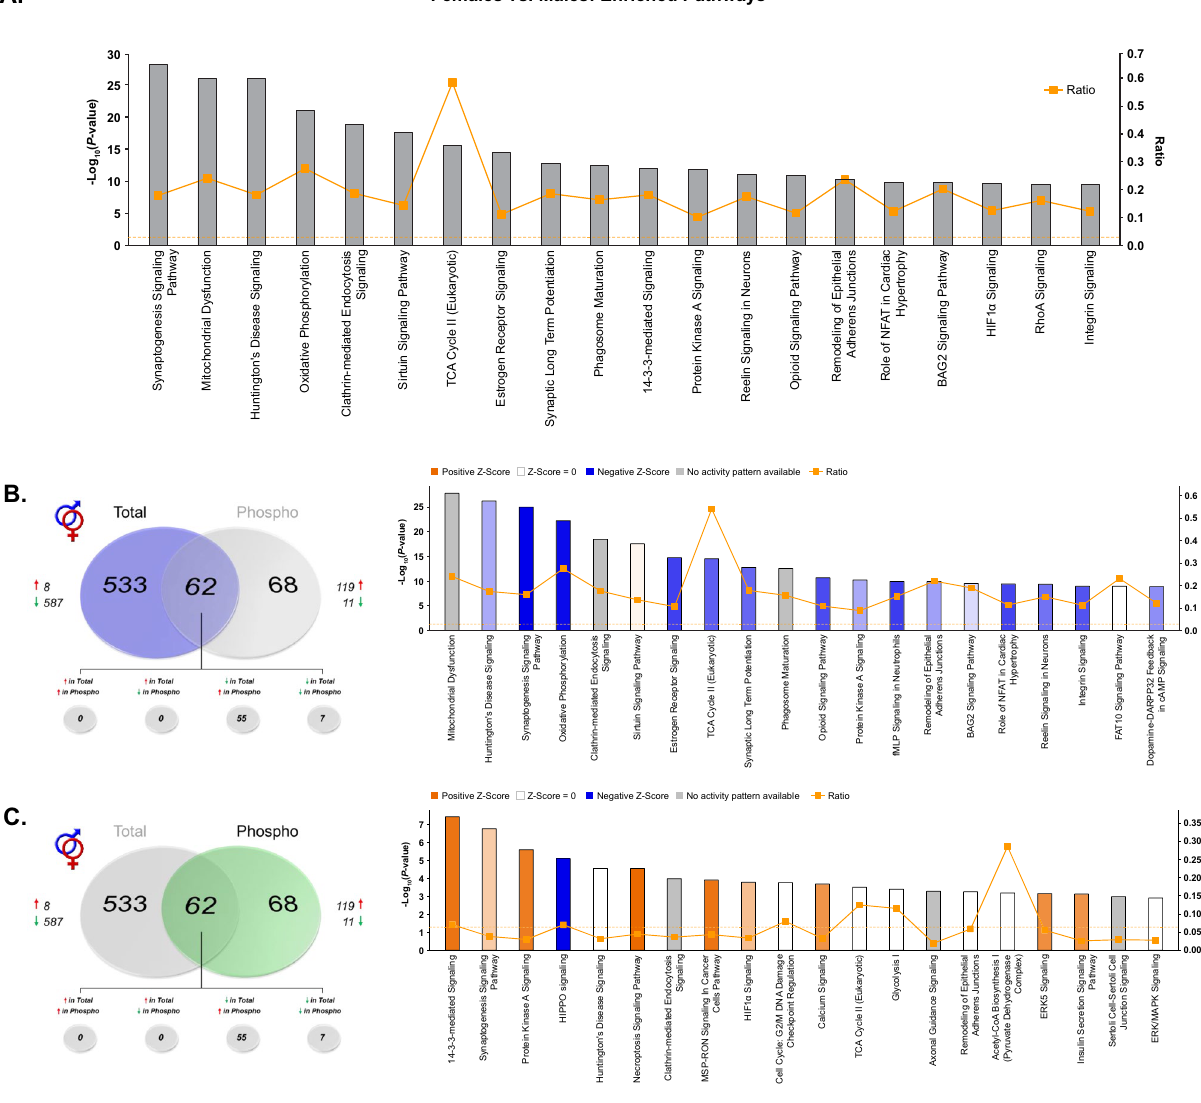
Figure 3. IPA enrichment analyses of differentially-abundant proteins and phosphoproteins between female and male rats. ( A ) Canonical pathway enrichment for combined list of proteins and phosphoproteins significantly differentially abundant between female and male rats. Separate IPA analyses of total ( B ) and phosphoproteins ( C ) with sex-dependent abundance describe contributions of each fraction to predicted activity levels within enriched pathways. Based upon the direction of fold change of significant differentially abundant proteins/phosphoproteins within the dataset, the Z -Score serves as a predictor of pathway activation states by assessing the match between the observed and predicted (evidence-based) up/down regulation patterns (see 41 ). Pathways are colored by predicted activation state: orange (activated) or blue (inhibited), where darker colors represent higher absolute Z -scores. Z-scores for pathways colored in gray could not be calculated due to insufficient evidence for a prediction of either activation or inhibition to be made. The ratio (solid orange line) represents the number of molecules within the comparison dataset meeting the cutoff criterion ( p < 0.05; Fisher’s Exact Test), divided by the number of molecules comprising a given pathway within the reference set (Ingenuity Knowledge Base). Bar graphs were produced in Ingenuity Pathway Analysis (IPA) software (QIAGEN,